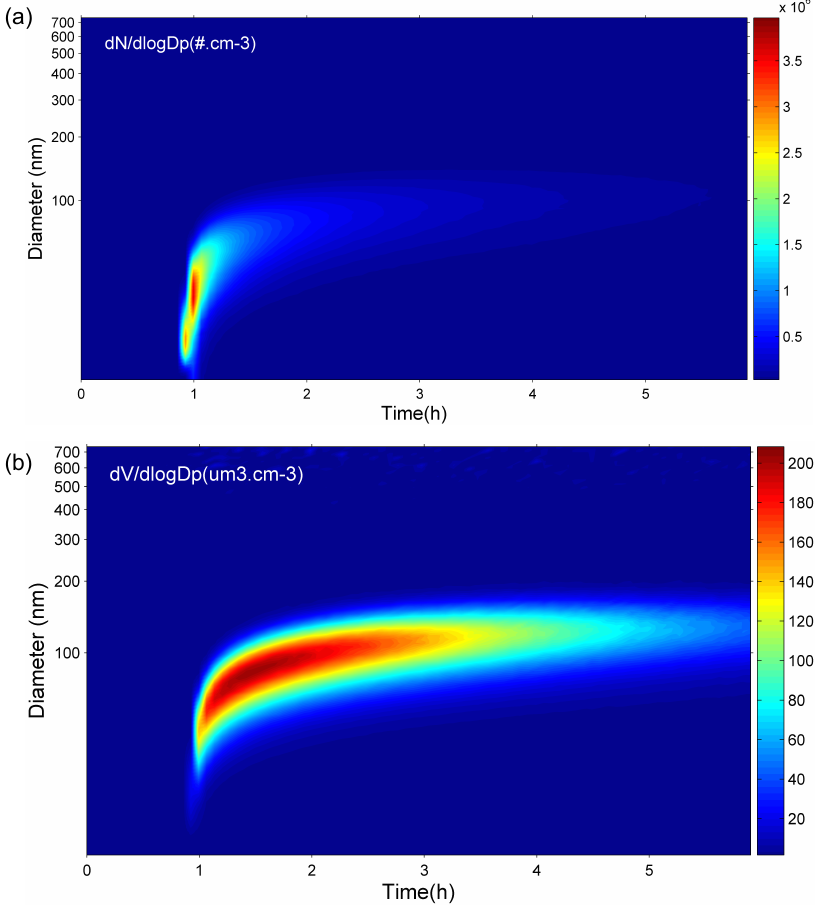
Figure 10. (a) Particle number (cm − 3 ) and (b) volume (µm 3 cm − 3 ) size distributions for experiment